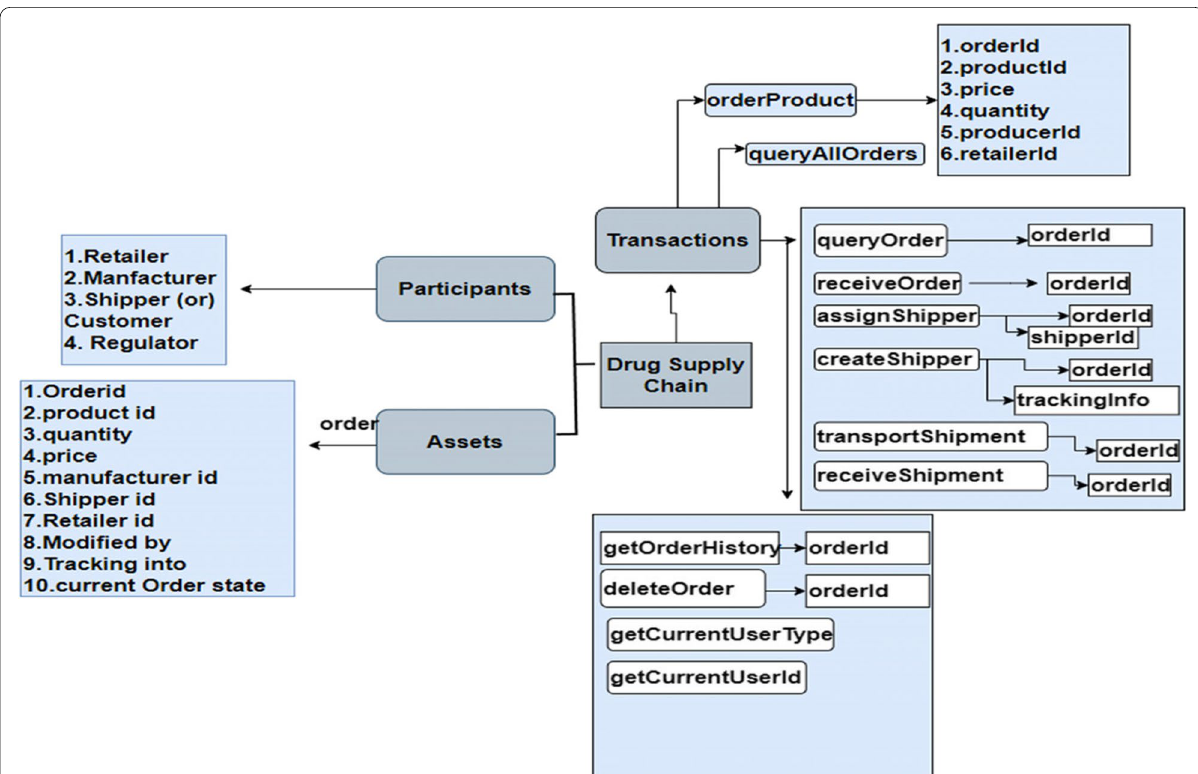
Fig. 7 Business Network of the Proposed